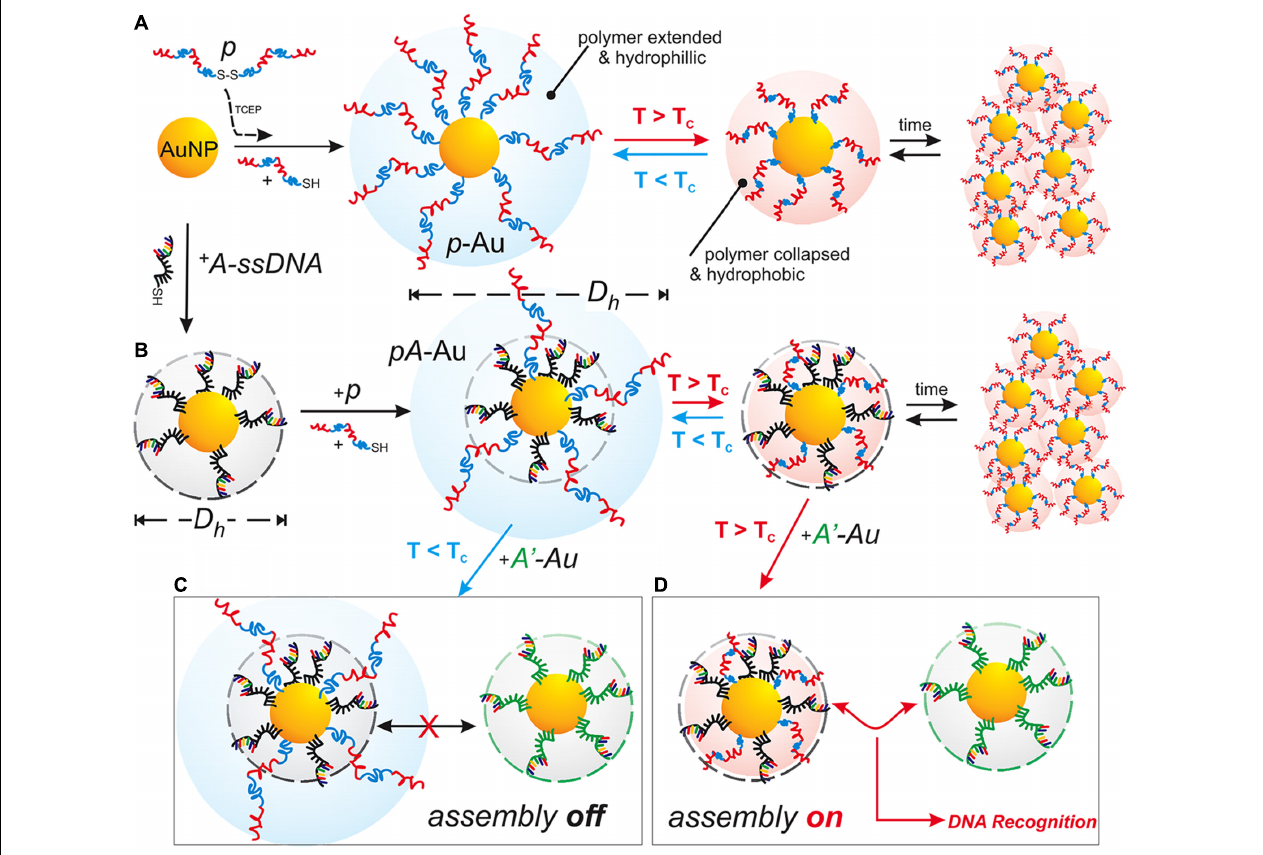
FIGURE 8 | Schematic Illustration of the temperature-responsive polymer systems. (A) The Au NPs were functionalized with freshly reduced pNIPAAm- co -pAAm copolymer ( p ), and the thermal response-based aggregation was measured. (B) The Au NPs were first functionalized with thiolated A -type ssDNA, then co-functionalized with p . The assembly of Ap -Au with complementary A’ -Au was then blocked at T < T C (C) , but promoted at T > T C (D) . Reprinted from Hamner KL, Alexander CM, Coopersmith K, et al. Using temperature-sensitive smart polymers to regulate DNA-mediated nanoassembly and encoded nanocarrier drug release. ACS Nano. 2013;7(8):7011–20. With permission from reference (Hamner et al., 2013). Au NPs, gold nanoparticles; Tc , critical